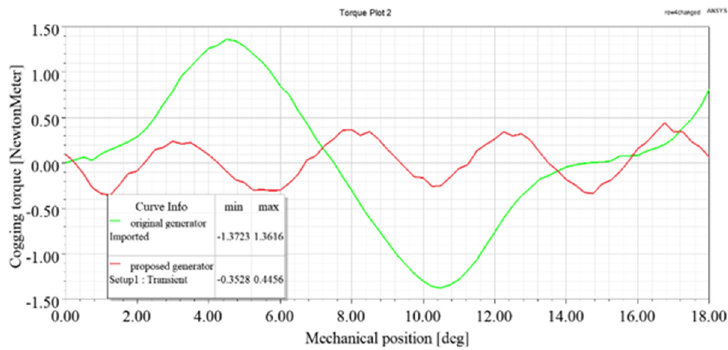
Figure 19. Cogging torque of original generator and proposed generator.